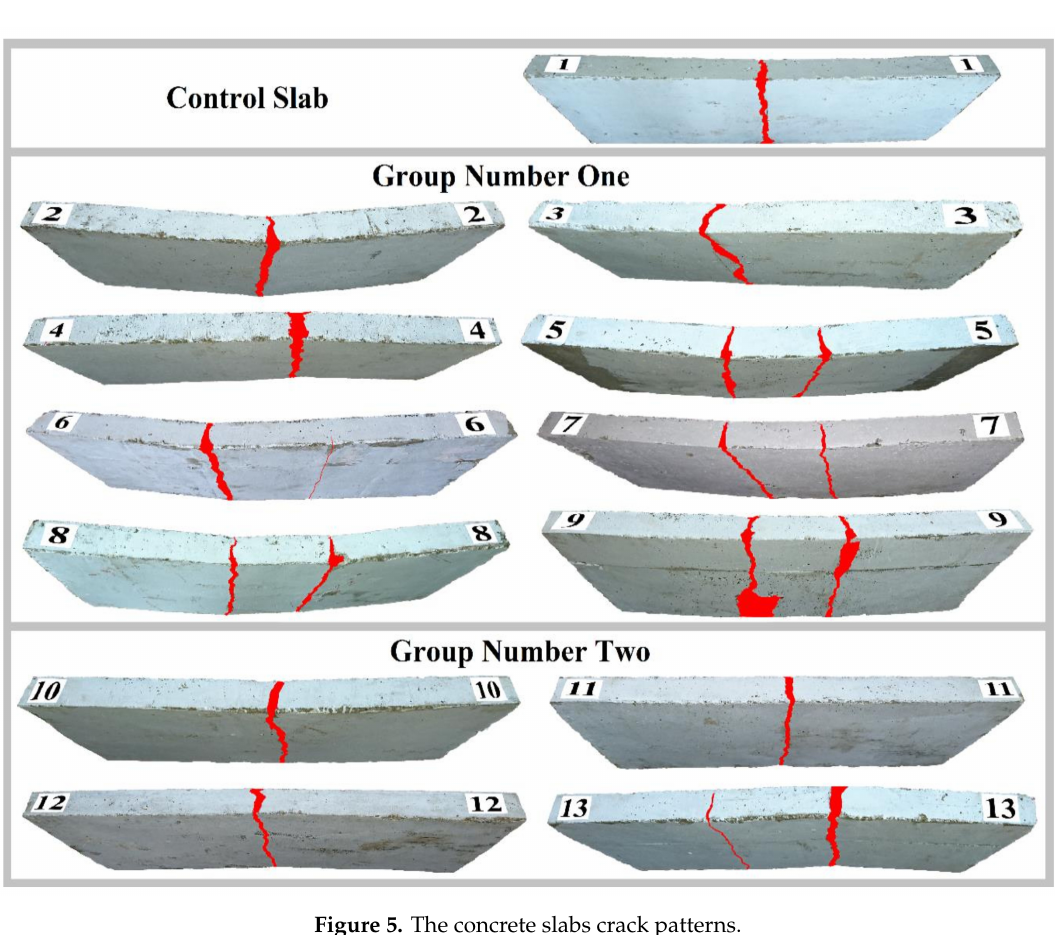
Figure 5. The concrete slabs crack patterns.